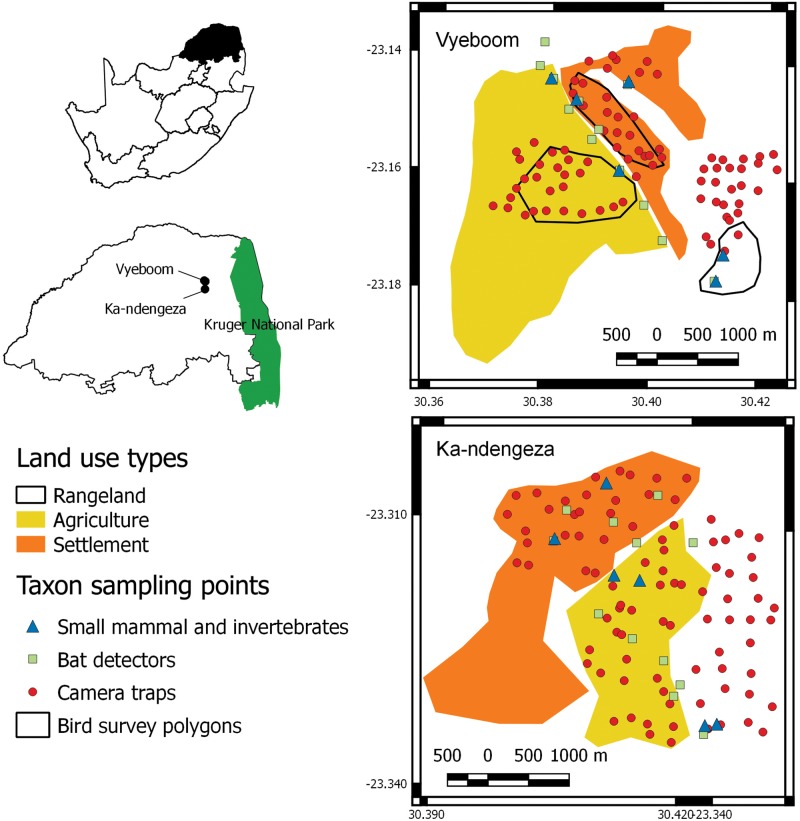
Map of study area indicating the three land use types and aerial photographs of each.Invertebrate and small mammal sampling grids are represented by their centroids, bird transects were conducted in Vyeboom and are represented by polygons. Point localities are given for camera traps and bat detectors.